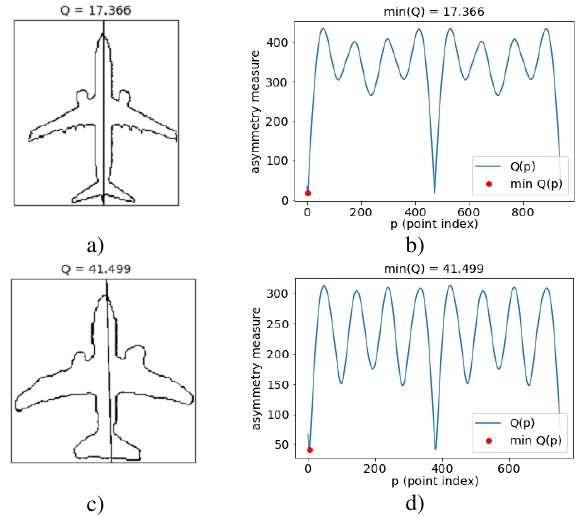
Figure 9. The symmetry axises of a) basic and c) noisy plane contours. Q is the asymmetry measure. The assymetry measure of b) the first and d) the second contours from different contour points.